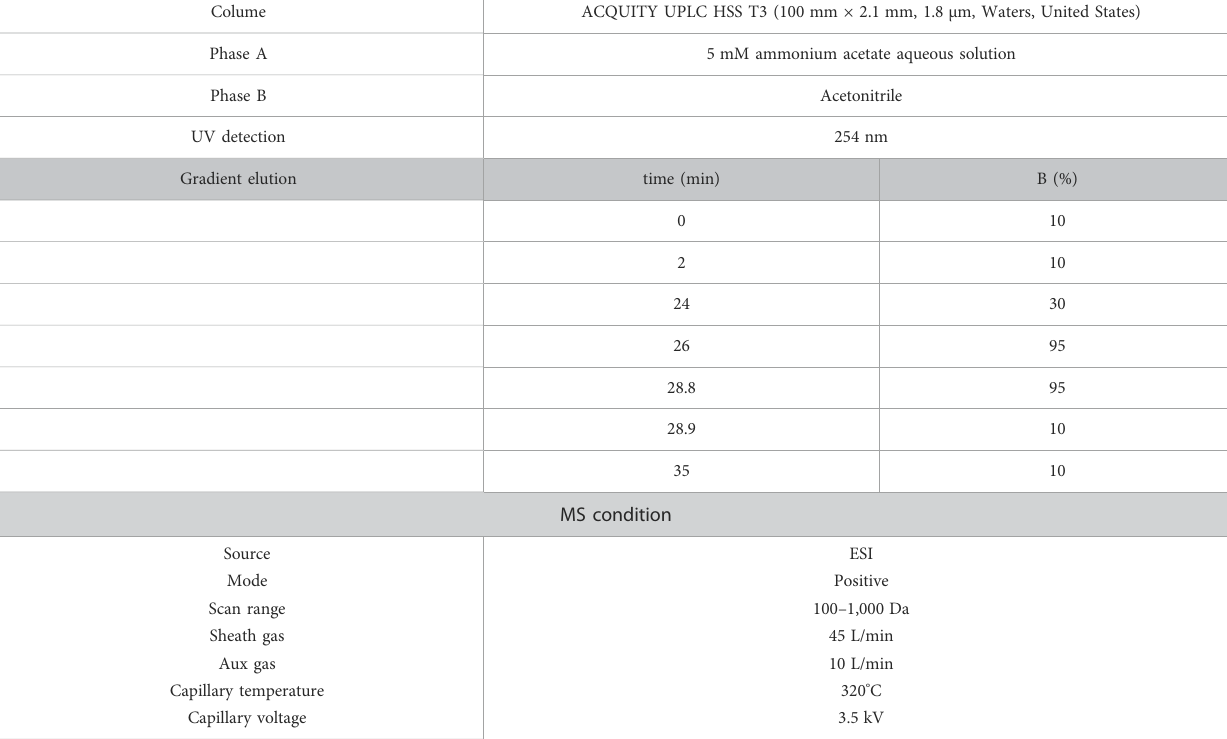
TABLE 1 UHPLC-HRMS setting.